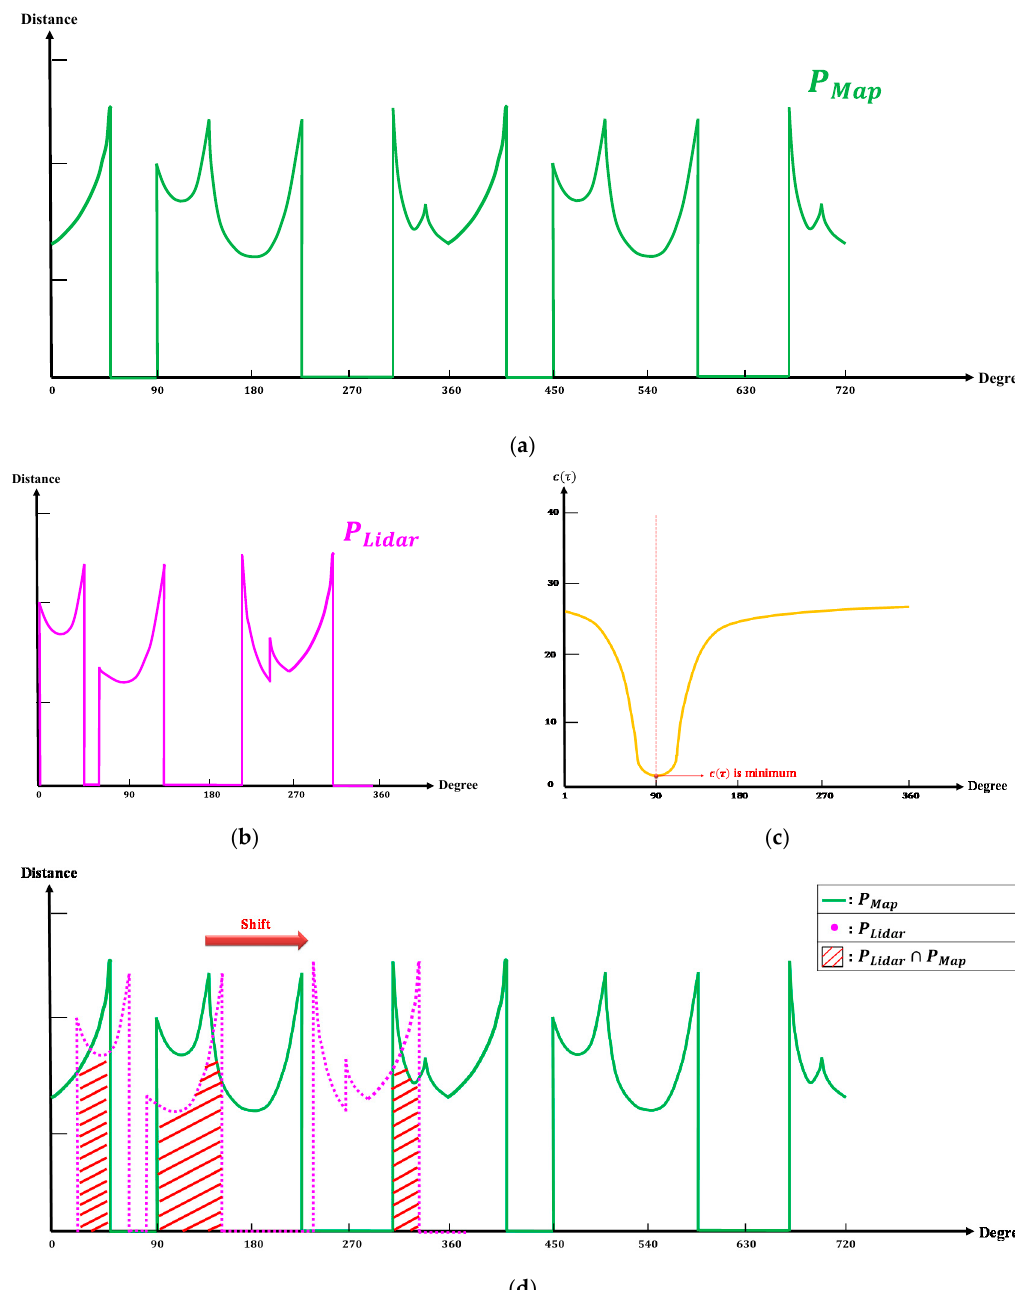
Figure 6. Registration of the map and LiDAR features. ( a ) Map features. ( b ) LiDAR on-site features. ( c ) Feature registration results. ( d ) Feature registration process.